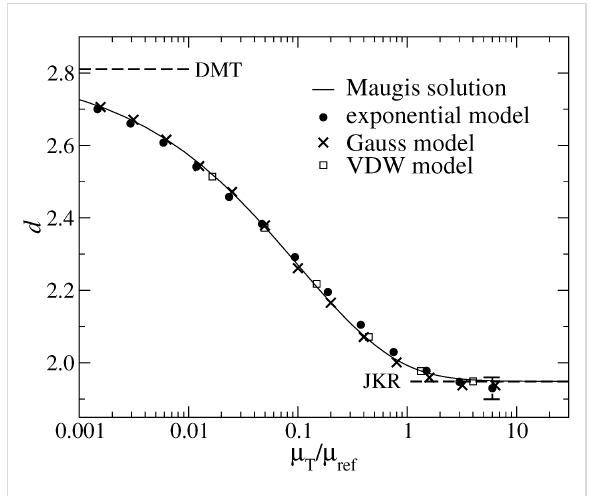
Figure 10: Normal displacement d at zero external load as a function of the Tabor coefficient μ T for different model interactions: exponential (full circles), Maugis Dugdale (straight lines), Gauss (crosses), and VDW (open squares). The Tabor coefficient was normalized so that all curves superimpose at the “half-way” distance d = ( d JKR + d DMT )/2. The upper and lower broken line denote the DMT and the JKR limits, respectively. Numerical uncertainties arise in the limit of large Tabor coefficients, as indicated by the error bar.